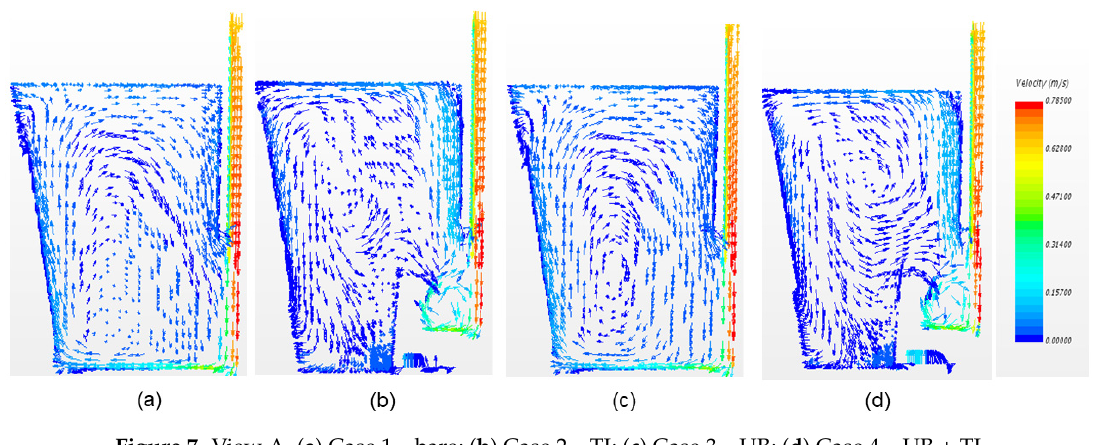
Figure 7. View A. ( a ) Case 1—bare; ( b ) Case 2—TI; ( c ) Case 3—UB; ( d ) Case 4—UB + TI.